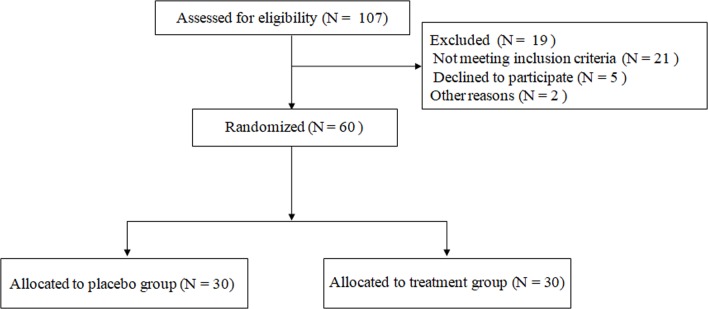
Flow diagram of patients selection in experiment 2.